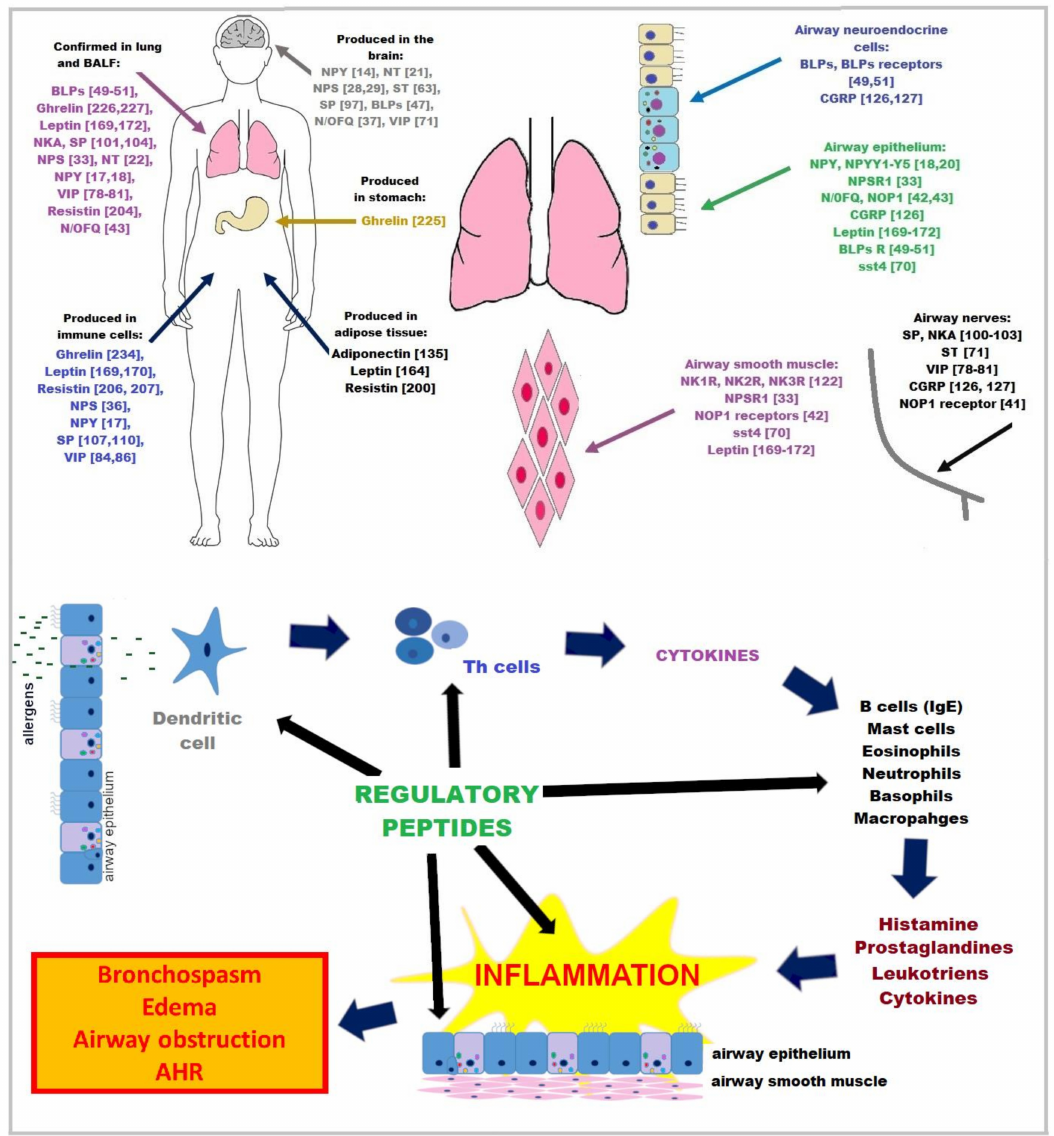
Figure 1. Localization of asthma-related regulatory peptides and their receptors in the body and in the lungs (upper panel). Lower panel shows the locations of regulatory peptide interactions that may influence the course of asthma. NPY, neuropeptide Y; NPS, neuropeptide S; BLPs, bombesin-like peptides; NKA, neurokinin A; SP, substance P; VIP, vasoactive intestinal polypeptide; N/OFQ, nociception; CGRP, calcitonin gene–related